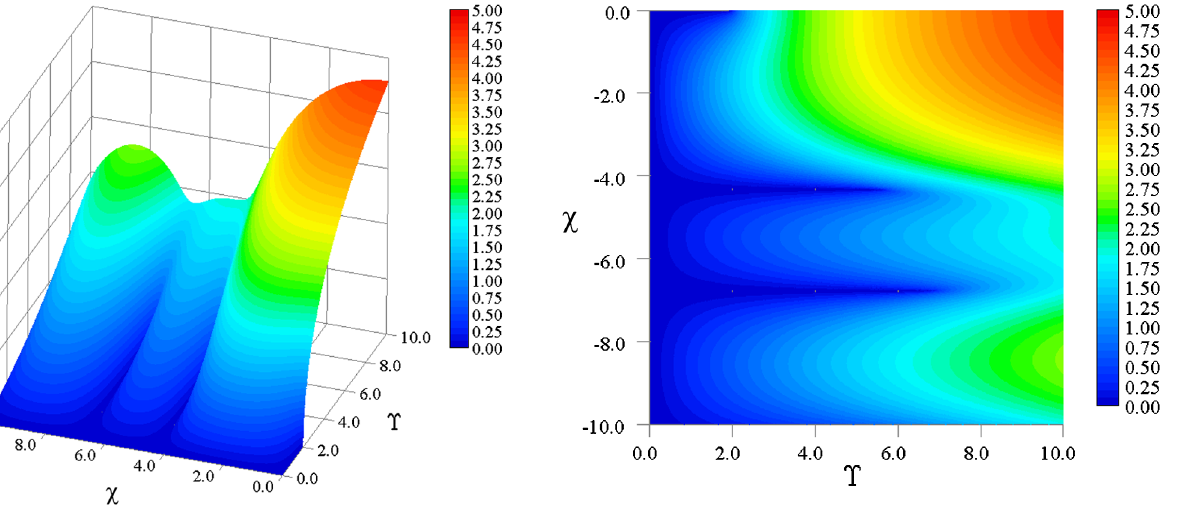
FIG. 4. Flat contour plot for the growth factor g × T function of ϒ and χ for negative χ .FIG. 2. Three-dimensional contour plot for the growth factor